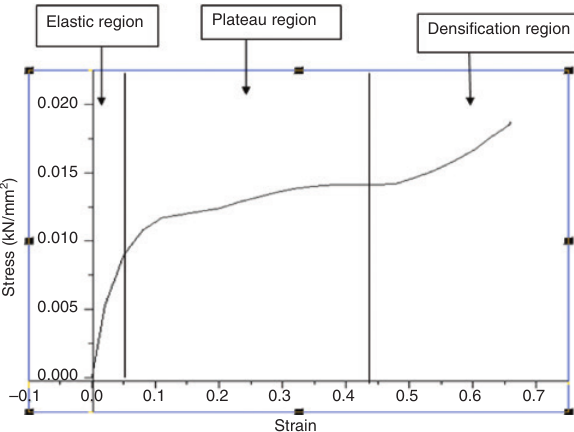
Figure 4: Compressive stress-strain curve of Foam-0.